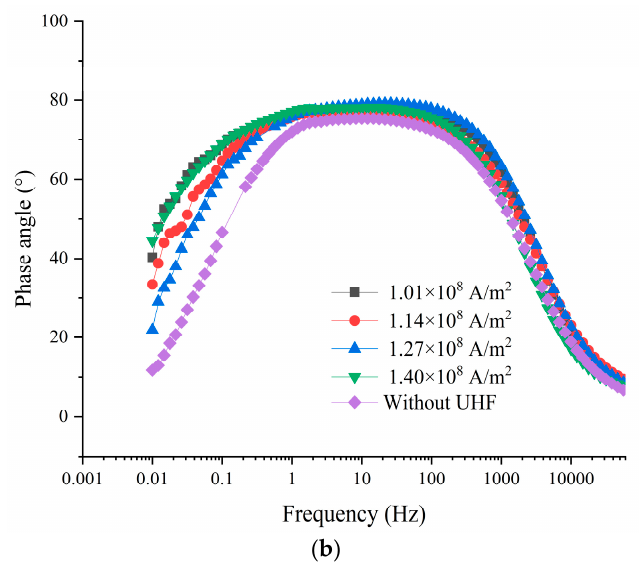
Figure 17. EIS spectra as Bode plot of the laser-UHF induction hybrid deposited layers under the current density: ( a ) frequency vs. amplitude ( b ) frequency vs. phase angle.